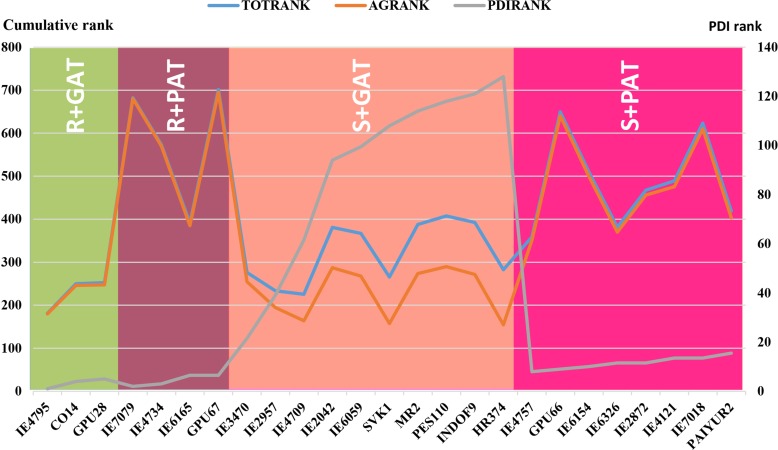
Empirical classification of top 25 ranking finger millet genotypes based on cumulative rank sum of agronomic traits and disease incidence percent; R+GAT, R+PAT, S+GAT and S+PAT.The remaining 103 genotypes belonged to the last category S+PAT.